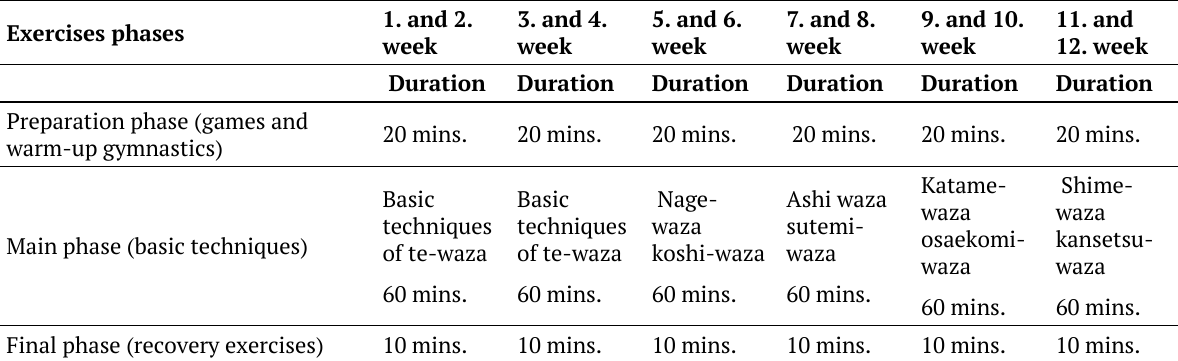
Table 1. Judo exercise program Exercises phases